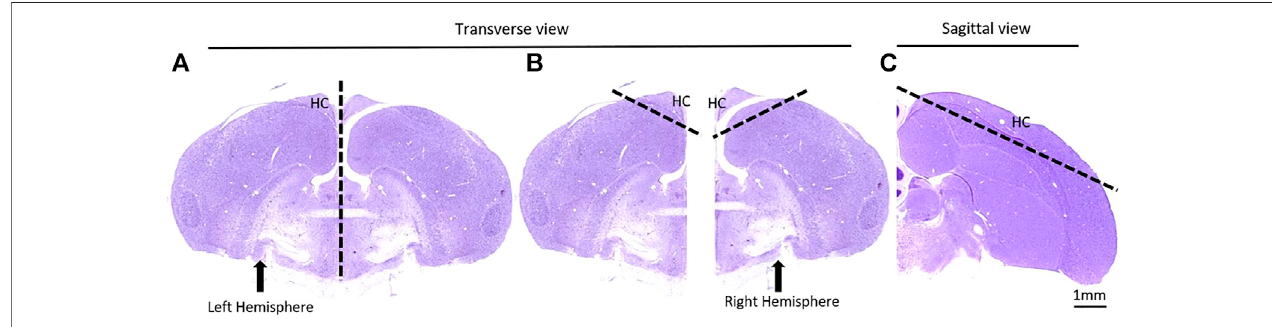
FIGURE 3 | A schematic depiction of the removal of the hippocampus (HC). (A) The brain was separated into the two hemispheres; (B) A generous 60 ° cut was made in both hemispheres to encapsulate all of the HC; (C) The same cut is shown in a sagittal view. Images adapted from Karten et al., 2008.